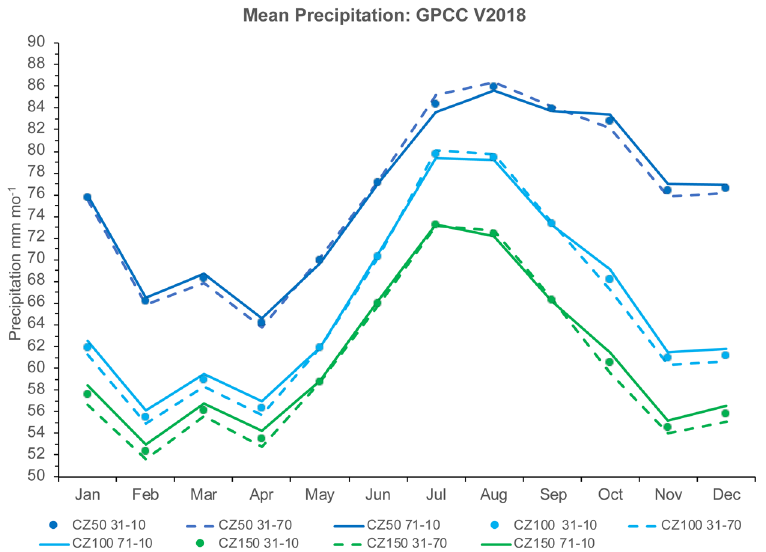
Figure 2. Annual cycle of coastal zone precipitation (mm mo − 1 ) for 1931 to 2010 (circles), 1931 to 1970 (dashed lines), and 1971 to 2010 (solid lines). CZ50 is in dark blue, CZ100 in cyan, and CZ150 in